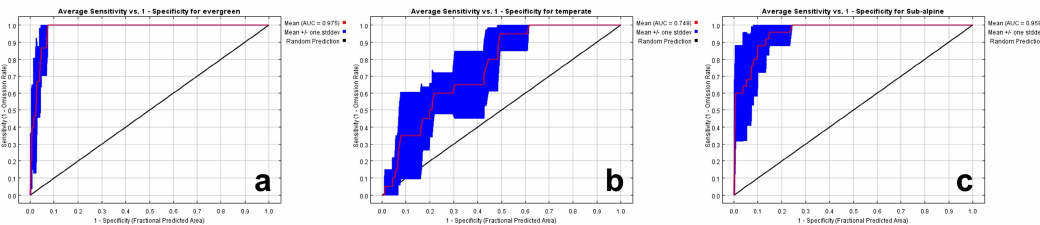
Figure 4. Evaluating habitat modeling performance using ROC and AUC (( a ): warm temperate evergreen forest; ( b ): temperate forest; ( c ): subalpine